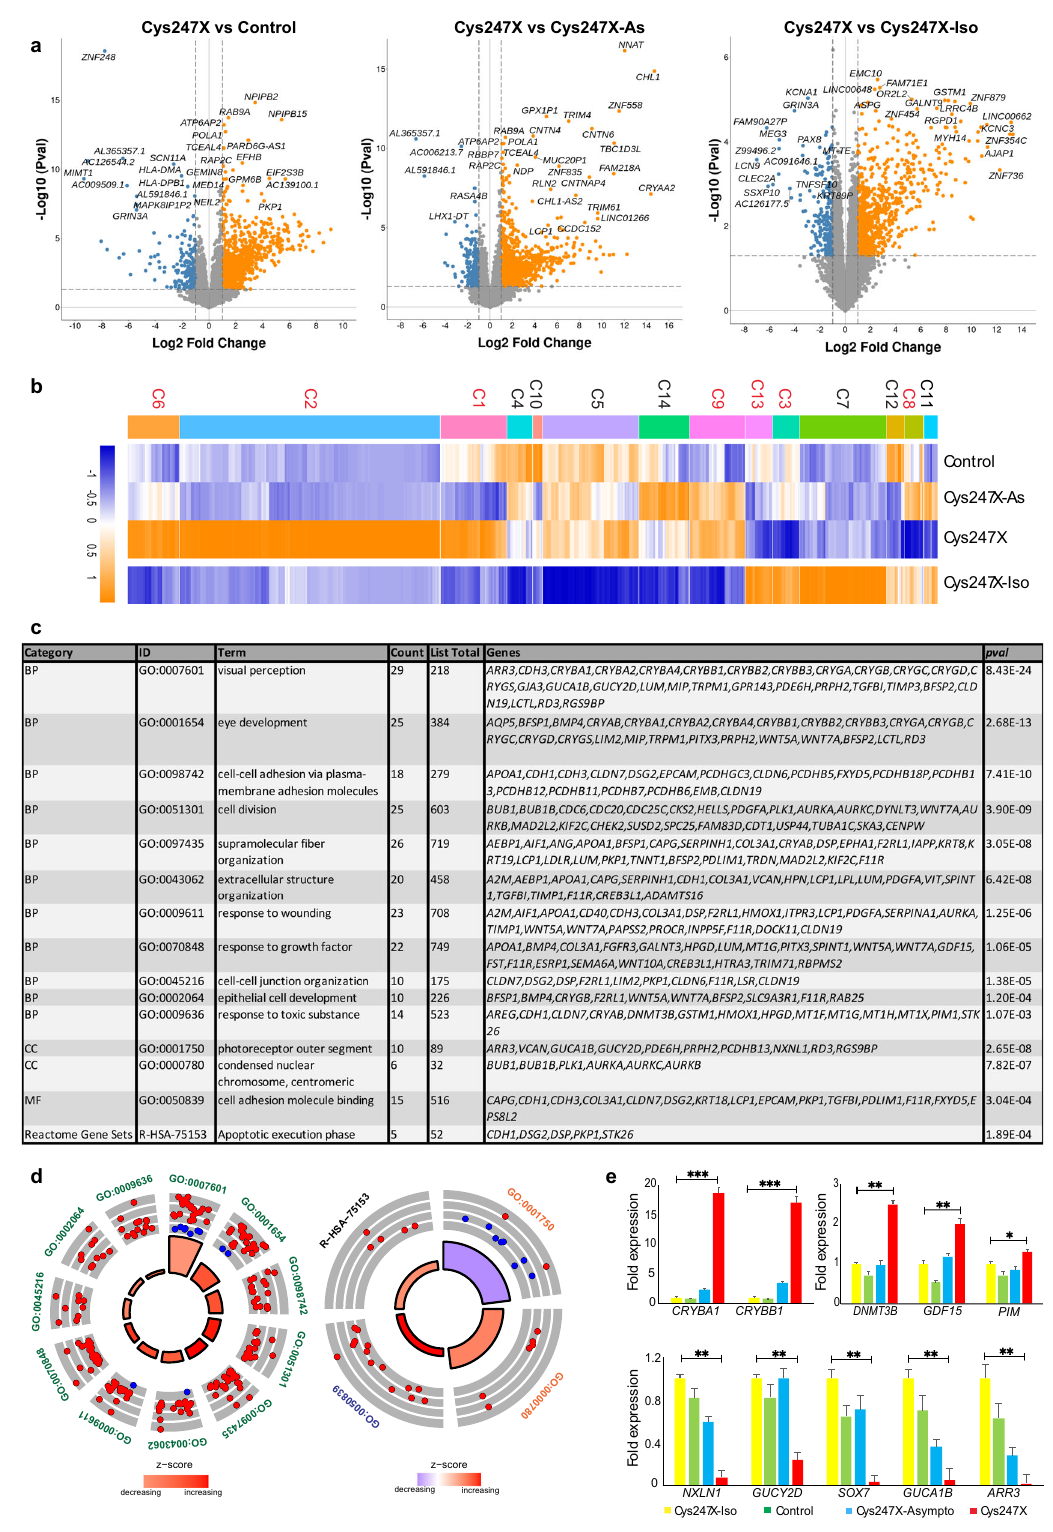
Cas9-repaired iPSCs to con fi rm speci fi city of the genotype- phenotype relationships. Precise gene repair of PRPF31 locus (exon 8) generated isogenic clones in which all the cellular and structural de fi ciencies observed in affected patient-derived RPE cells and retinal organoids were reversed, demonstrating that